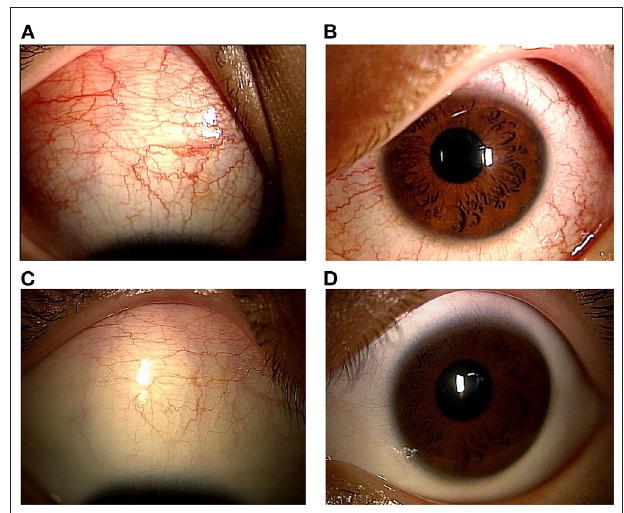
FIGURE 1 | Ophthalmological slit-lamp examination before and after the intravenous immunoglobulin (IVIG) administration. Right (A) and left (B) slit-lamp photographs show bilateral conjunctival, episcleral and scleral njection, suggesting scleritis and concomitant conjunctivitis. Right (C) and left (D) slit-lamp photographs after IVIG administration, showing the dramatic improvement in their ocular findings.